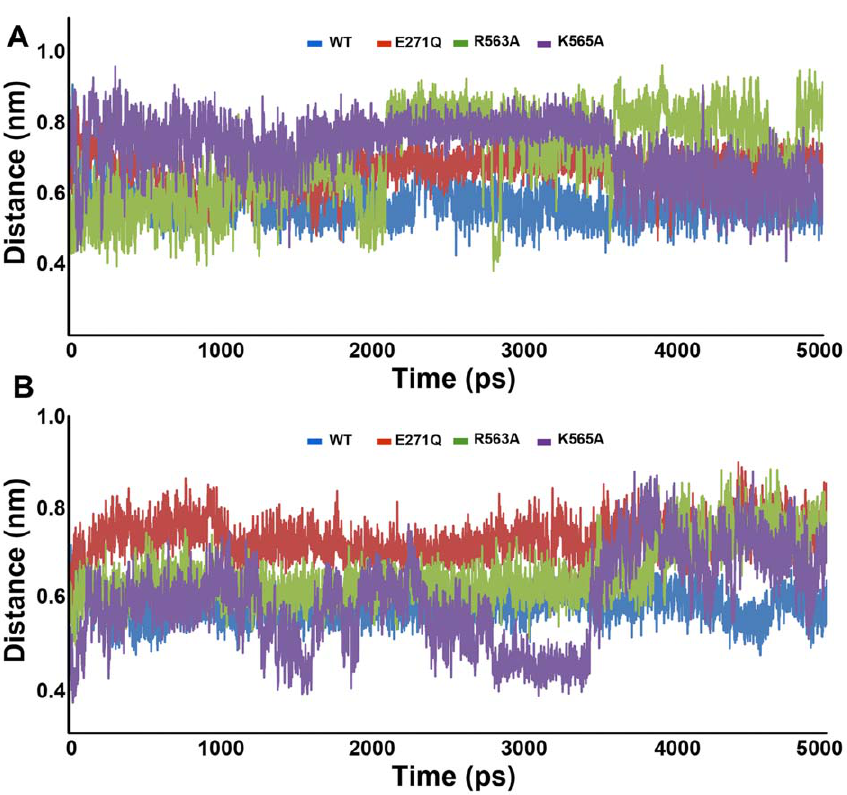
Figure 5. The calculated distances between the catalytically important moieties of the system. (A) Distance between the metal ion and the epoxy oxygen atom of LTA4. (B) Distance between the metal ion and carbonyl oxygen atom of the N-terminal peptide bond of RAR.